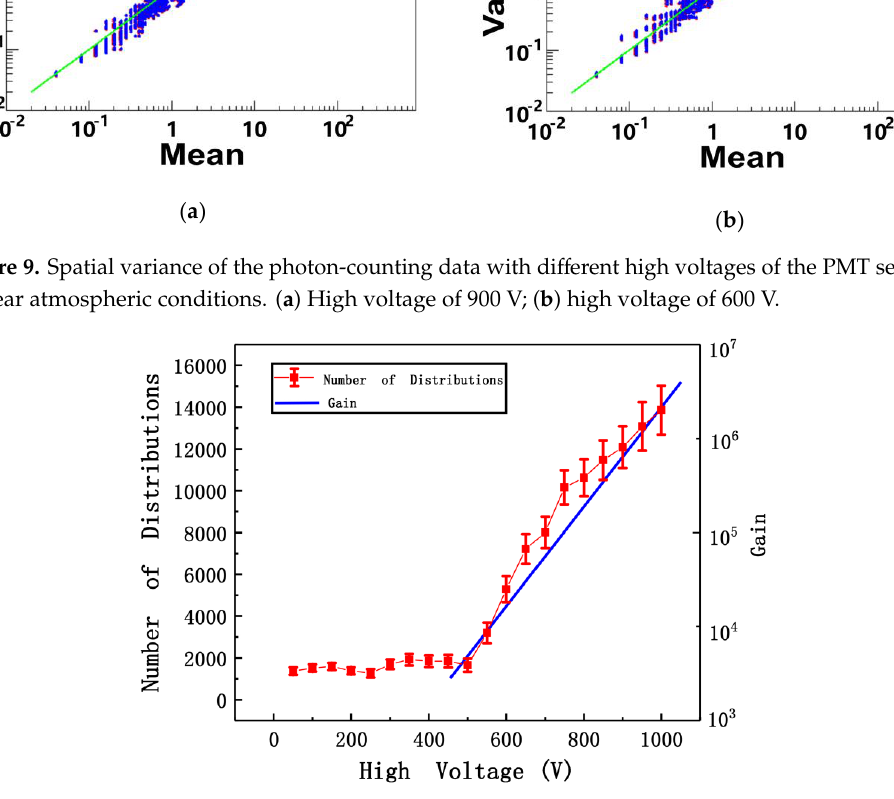
Figure 10. The number of non-zero photon-counting data distributions with different high voltages of PMT settings under clear atmospheric conditions, and the gain curve of the PMT.